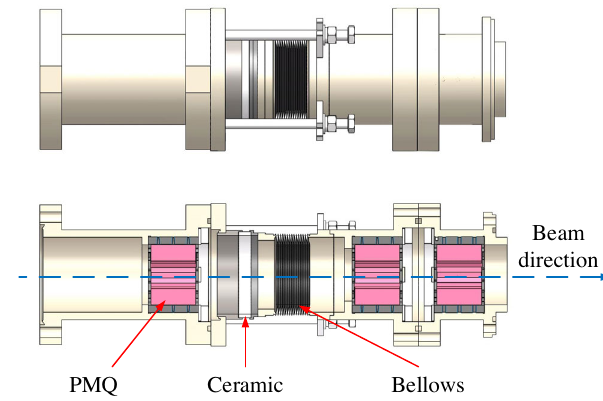
FIG. 10. Mechanical design of the